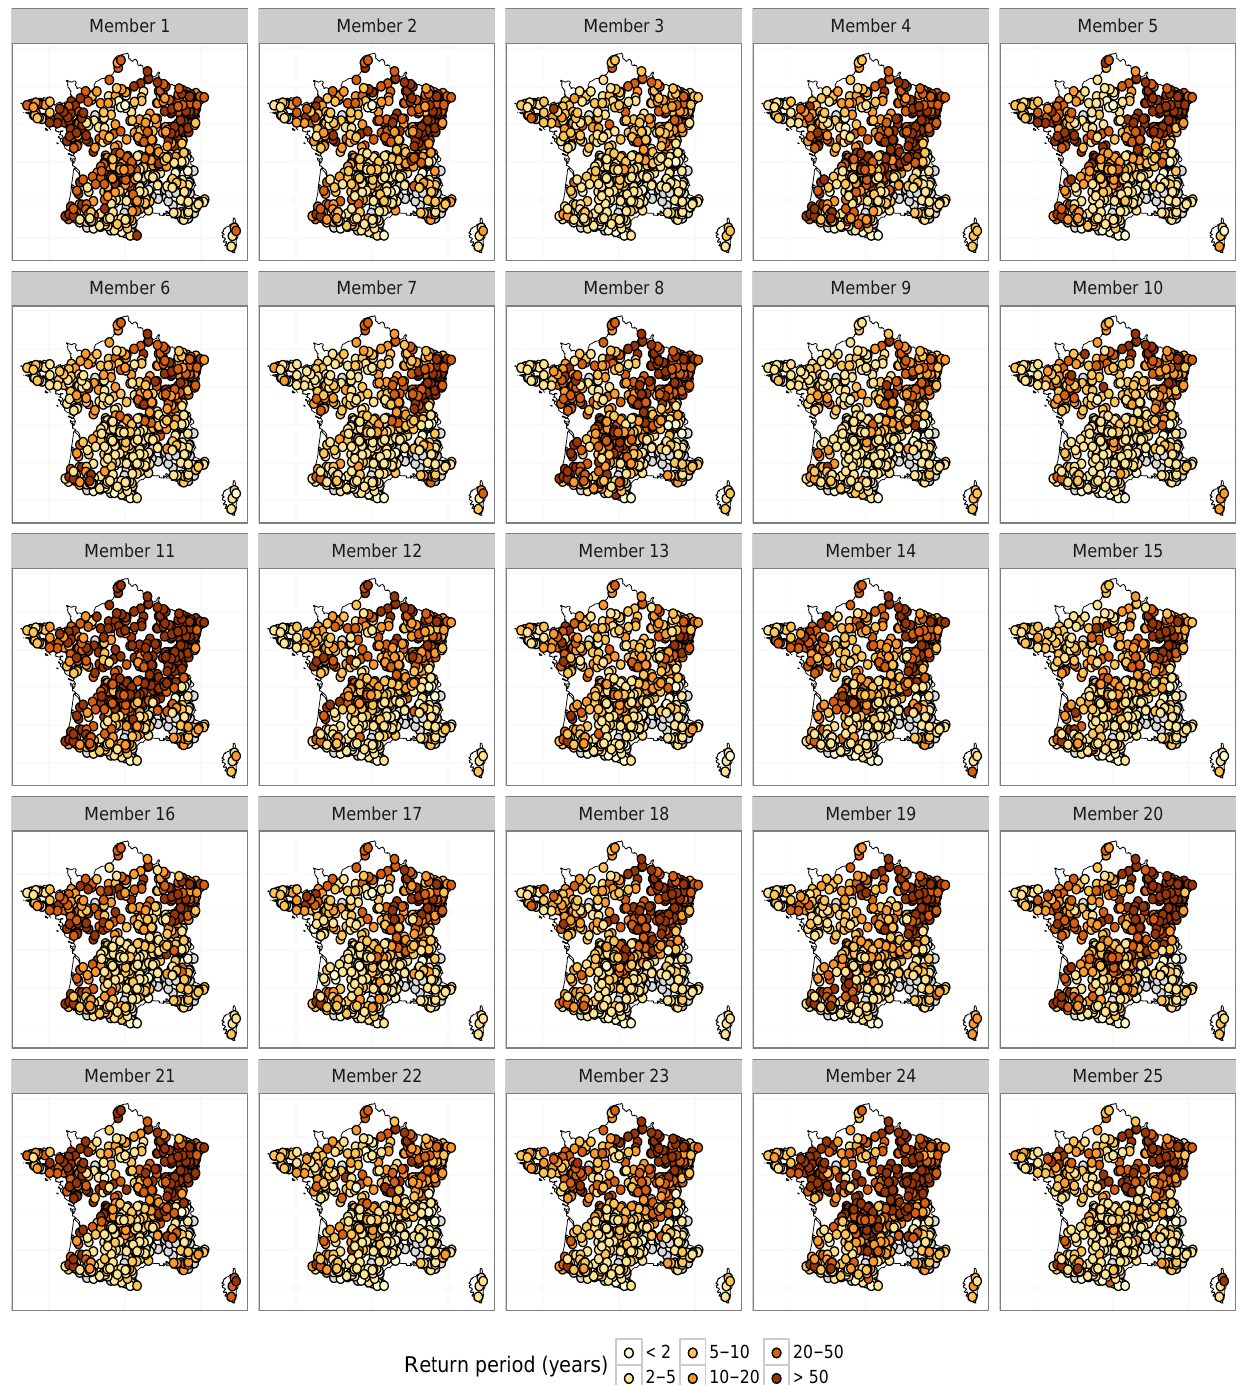
Figure 17. Return period in severity for the 25 ensemble members of the 1893 event. Filled grey circles represent stations that did not detect the